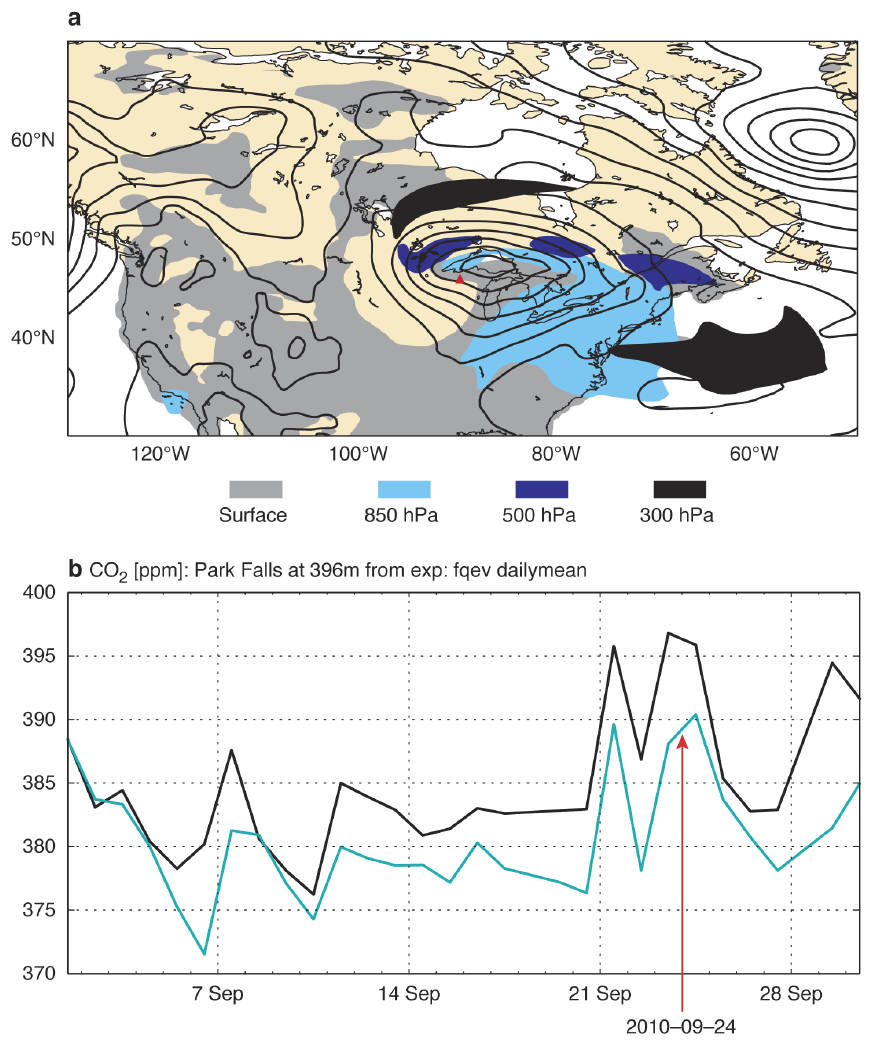
Figure 13. Atmospheric CO 2 anomalies associated with the passage of a low pressure system over N. America: ( a ) CO 2 anomalies above the well-mixed background CO 2 at different levels in the vertical: grey near the surface, cyan at 850 hPa, blue at 500 hPa and dark grey at 300 hPa on 24 September 2010. The anomalies are defined as CO 2 dry molar fraction above the background value of 392 ppm for both near the surface and at the 850 hPa levels, and above the background value of 388 for the 500 and 300 hPa levels. The locations of the observing site of the Park Falls Tower (Wisconsin, USA) is depicted by a red triangle. The black contours of mean sea level pressure show the location of the centre of low pressure systems; ( b ) daily mean dry molar fraction (ppm) of CO 2 from measurements (black) and forecasts (cyan) at Park Falls in September 2010. The observations are courtesy of NOAA Earth System Research Laboratory